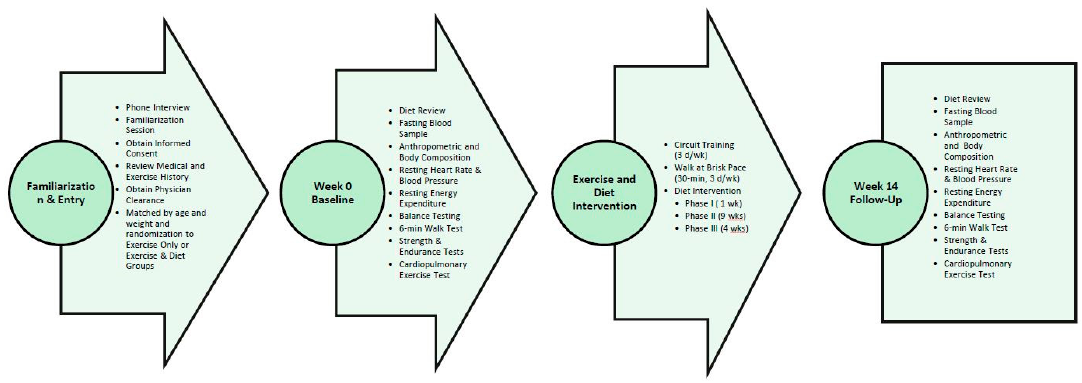
Figure 2. Overview of study testing and timeline.